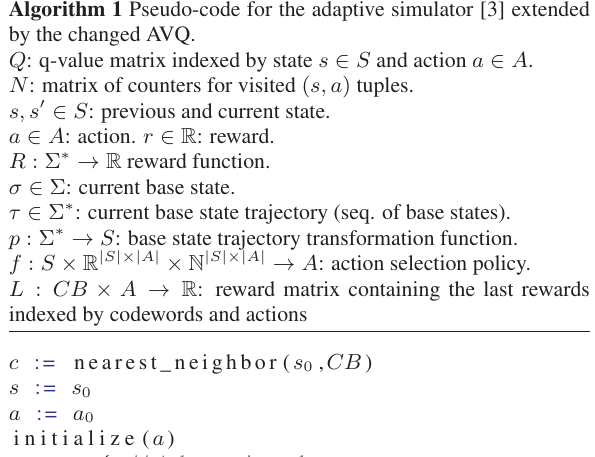
Algorithm 1 Pseudo-code for the adaptive simulator [3] extended